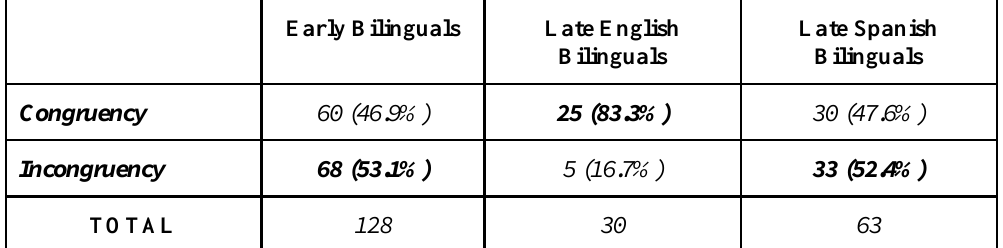
Table 12. Congruency preference by bilingual type for forced toy task (Stimuli with Spanish feminine translation equivalents)